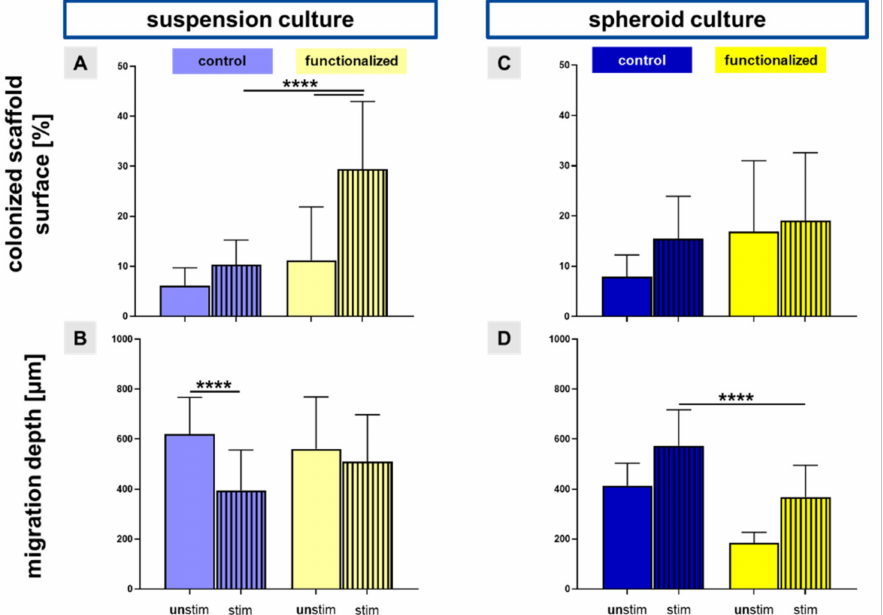
Figure 3. The statistic evaluation of the colonized scaffold surface and the migration depth into the scaffolds seeded with the suspension and the spheroid culture. Based on the vitality assay, the colonized scaffold surface (( A ) suspension and ( C ) spheroid pre-culture ) was evaluated. The migration depth of the cells into inner parts of the scaffolds (( B ) suspension and ( D ) spheroid pre- culture ) was measured after a DAPI staining of longitudinal sections. Control (non-functionalized, blue bars) and functionalized (yellow bars) scaffolds, seeded with two different colonization strategies (suspension: dynamically pre-cultured for 24 h and spheroid: statically pre-cultured for 5 days) were compared as well as unstimulated (unstim: full bars) against stimulated (72 h, 4% stretch, 0.11 Hz, stim: striped bars). One-way ANOVA test with Tukey post hoc test showed significant differences (****) with p ≤ 0.0001. Three independent experiments with cells of three different donors were